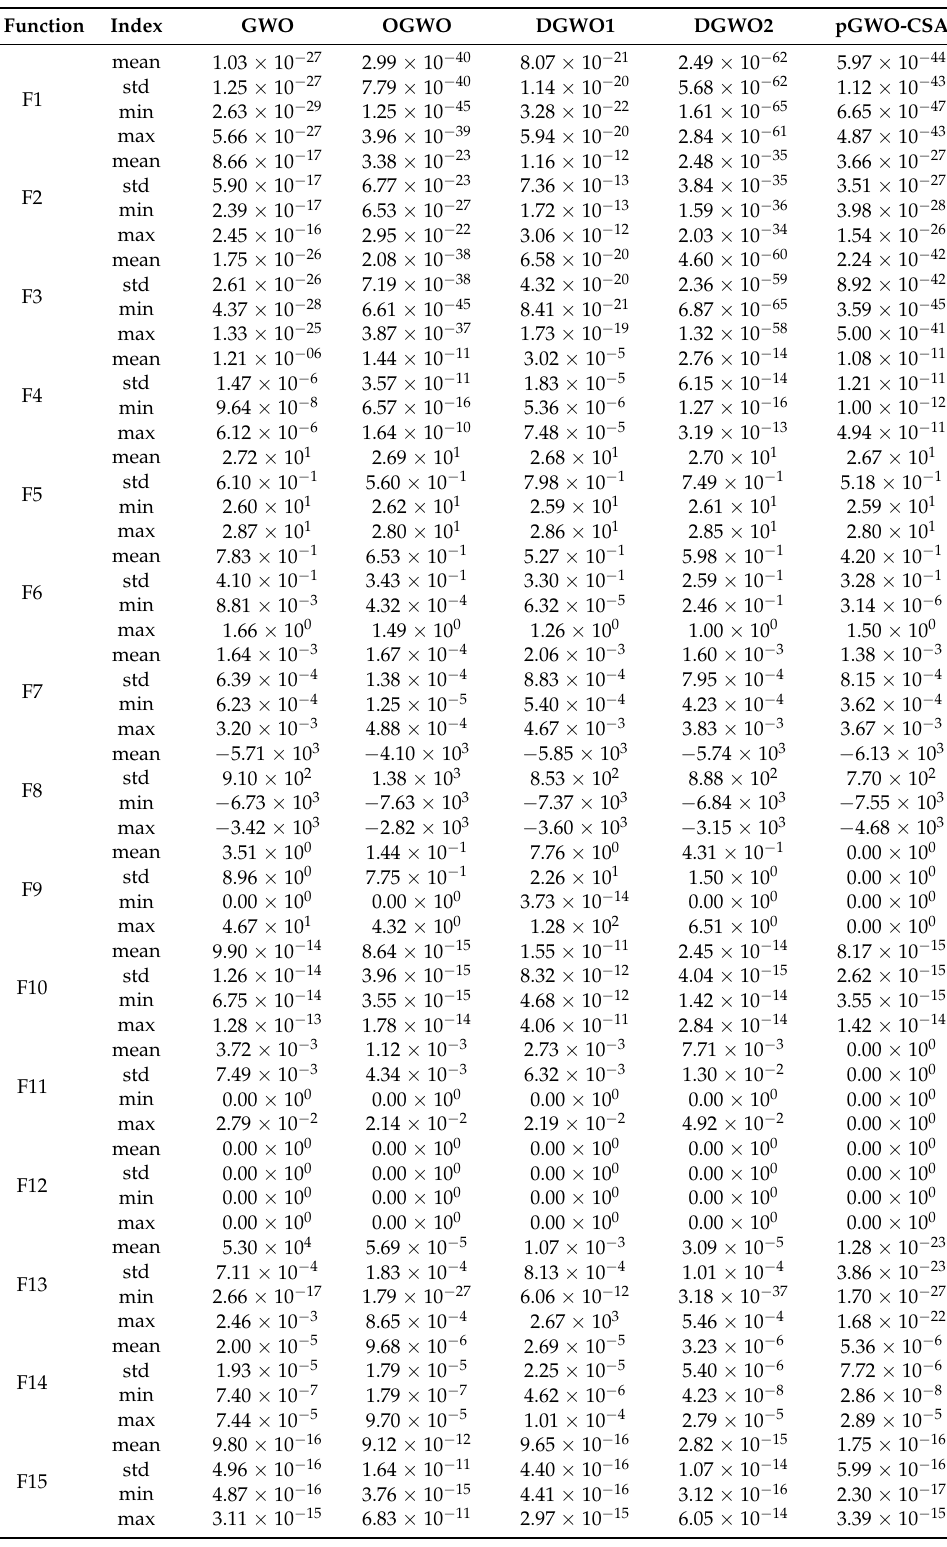
Table 6. The experimental results under 30